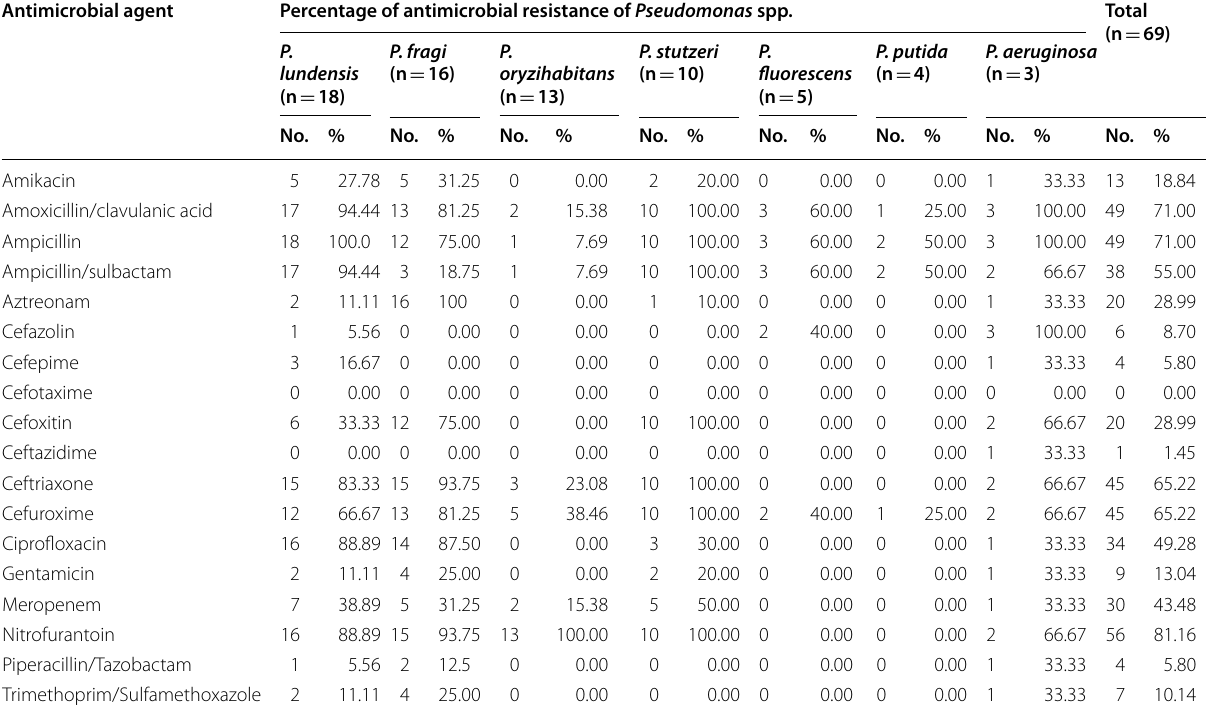
Table 5 Direct screening of the antimicrobial susceptibilities of certain Pseudomonas spp. by the VITEK AST GN83 cards Antimicrobial agent Percentage of antimicrobial resistance of Pseudomonas